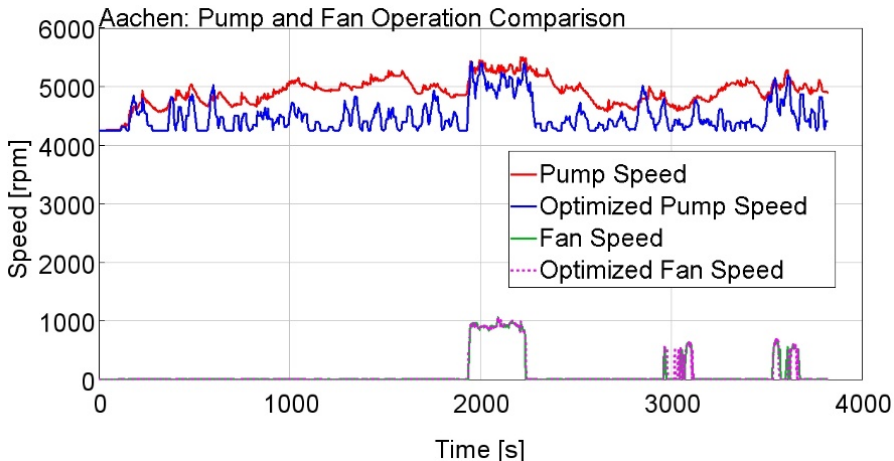
Figure 24. Control strategy comparison for dual IDM on Aachen driving cycle: coolant pump speed (top); radiator fan speed (bottom).